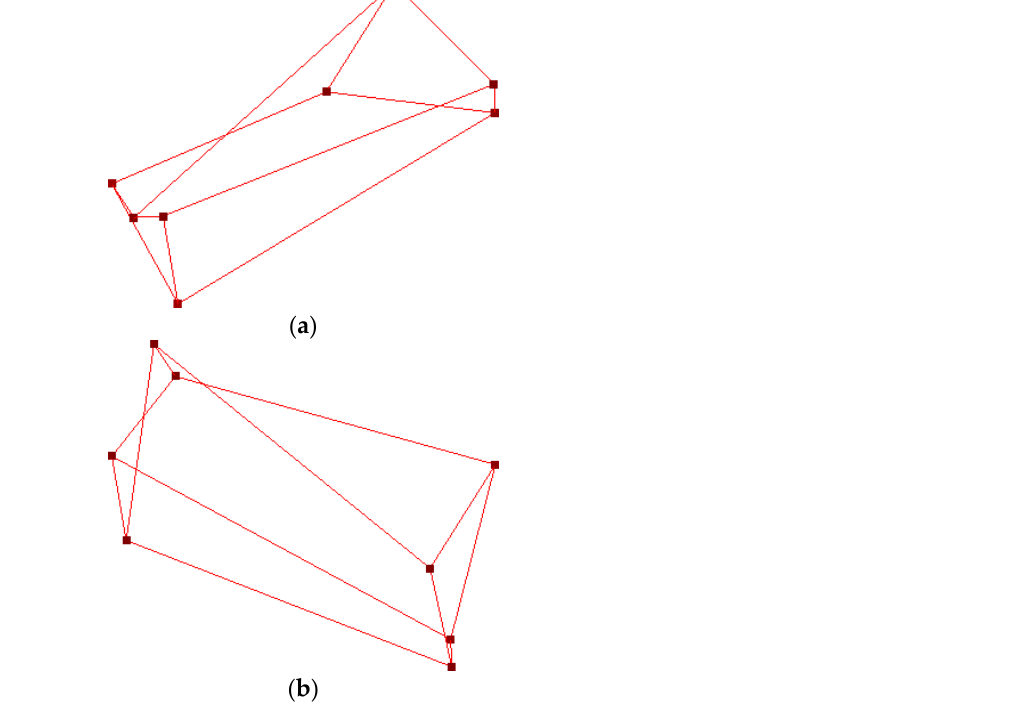
Figure 11. PSD of two excitation signals from EMA when stationary experiment. Similarity of these curves present the repeatability of the EMA experiments.